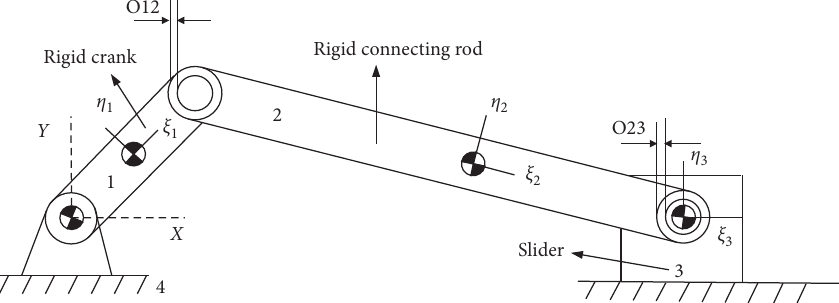
Figure 2: Slider-crank mechanism with two revolute clearance